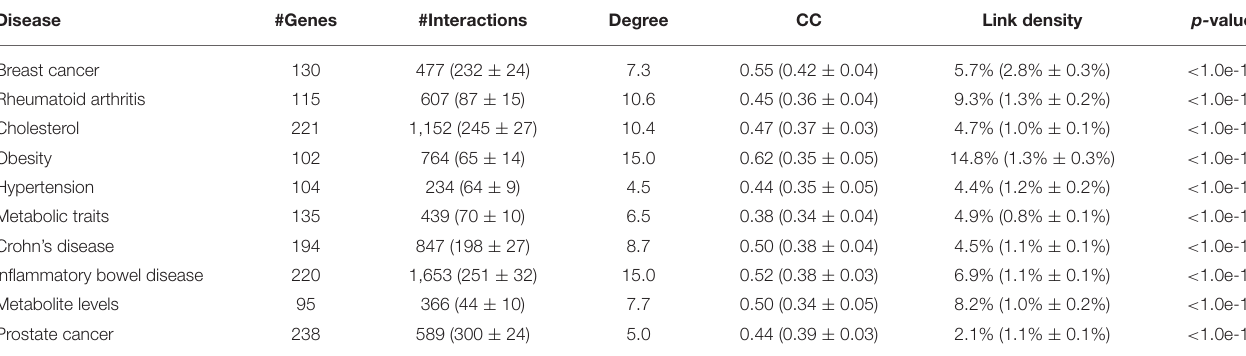
TABLE 1 | Statistics of disease-gene subnetworks related to breast cancer as well as other diseases.